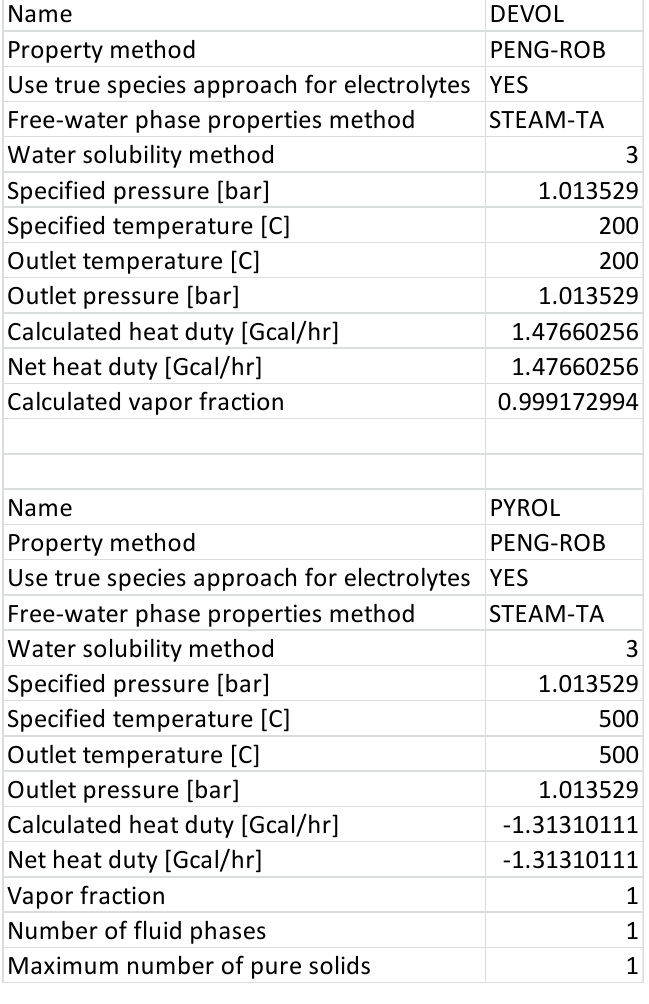
Figure A5. Pyrolysis devol and pyrol results.